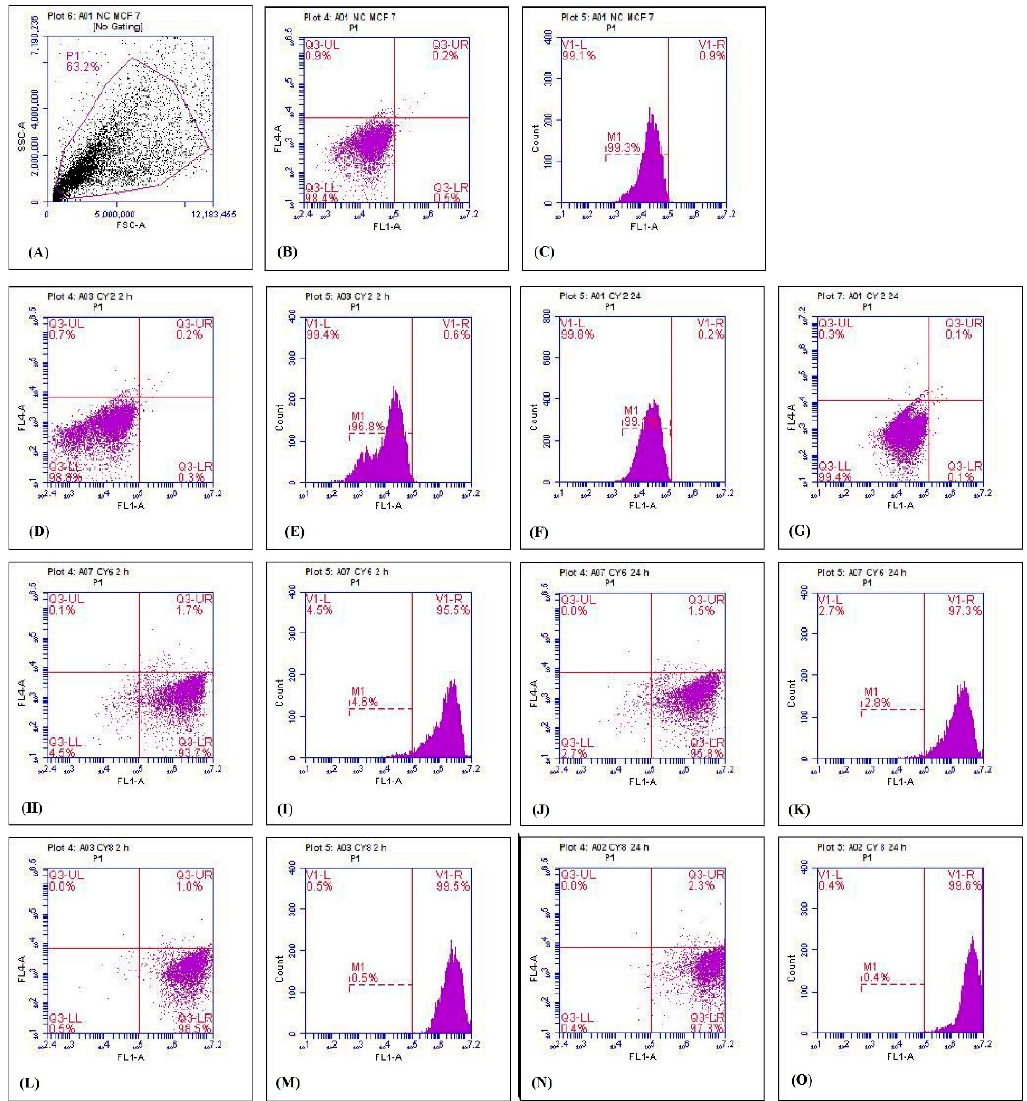
Figure 7. Cellular uptake study using flow cytometry: ( A ) gating, ( B , C ) fluorescence of untreated MCF-7 cells, ( D , E ) fluorescence of blank nanoparticles at 2 h, ( F , G ) fluorescence of blank nanoparticles at 24 h, ( H , I ) fluorescence of unconjugated nanoparticles at 2 h, ( J , K ) fluorescence of unconjugated nanoparticles at 24 h, ( L , M ) fluorescence of DCT-loaded Tf-conjugated PLGA NPs at 2 h, ( N , O ) fluorescence of Tf-conjugated PLGA NP at 24 h. The x- and y-axes correspond to forward scatter (FSC) (which measures size) and side scatter (SSC) (which measures internal complexity), respectively. The FL1-area stands for total cell fluorescence. Table 7. Mean fluorescence analysis of MCF-7 cells 2 h and 24 h after treatment with blank